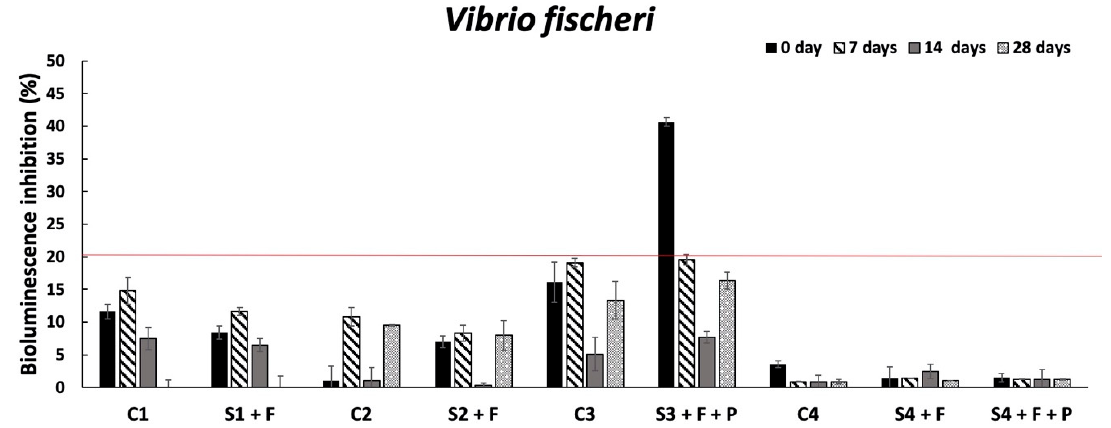
Figure 1. Inhibition of bioluminescence (%) of Vibrio fischeri exposed to elutriates from conditioned (S1 + F, S2 + F, S3 + F + P, S4 + F, S4 + F + P) and control (C1, C2, C3, C4) soils at different experimental times (0, 7, 14 and 28 days). The bars represent the standard errors. The red line represents the threshold of toxicity (20%).